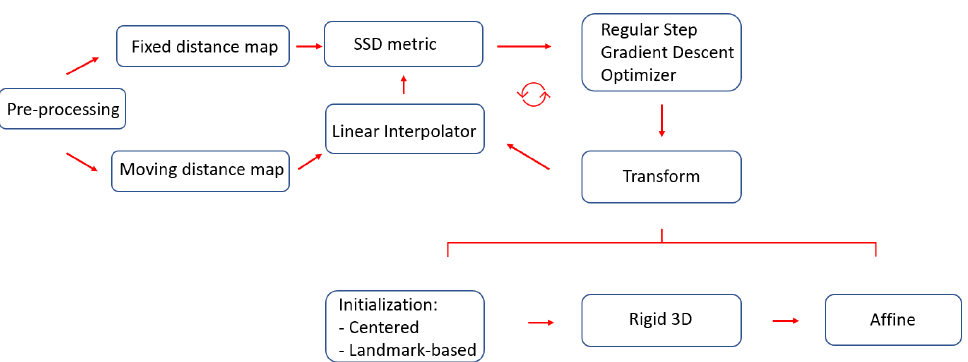
Figure 7. The proposed registration workflow starts with preprocessing segmentation masks, to make them isotropic with the same resolution. Thereafter, SSD is employed as a metric to perform the registration, where gradient descent is adopted as the optimizer. Two kinds of initialization were considered: one based on centers and the other based on